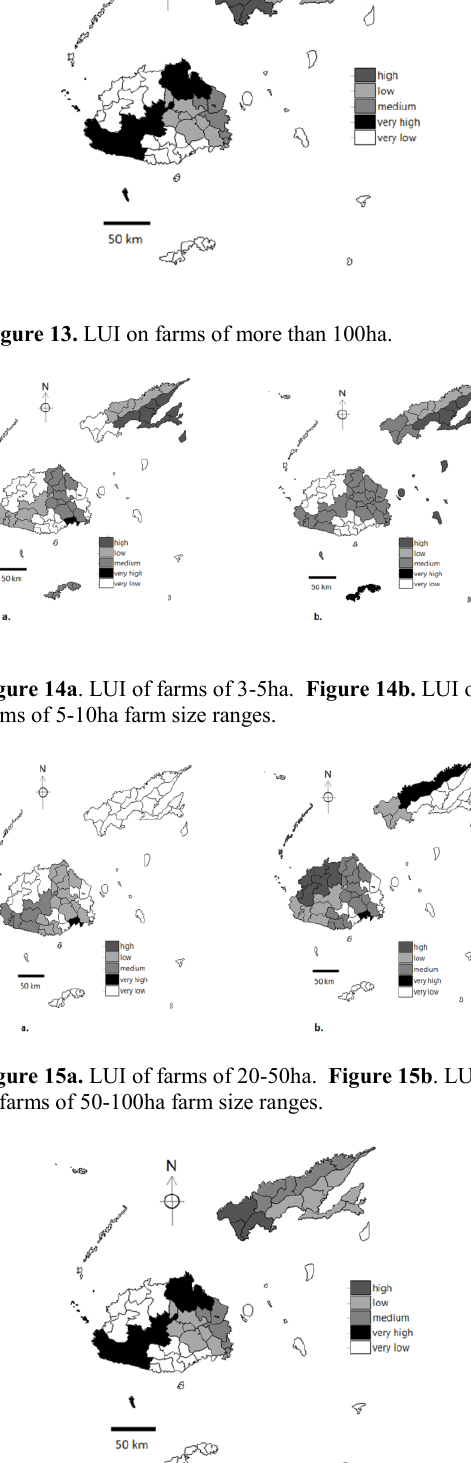
Figure 16. LUI on farms of more than